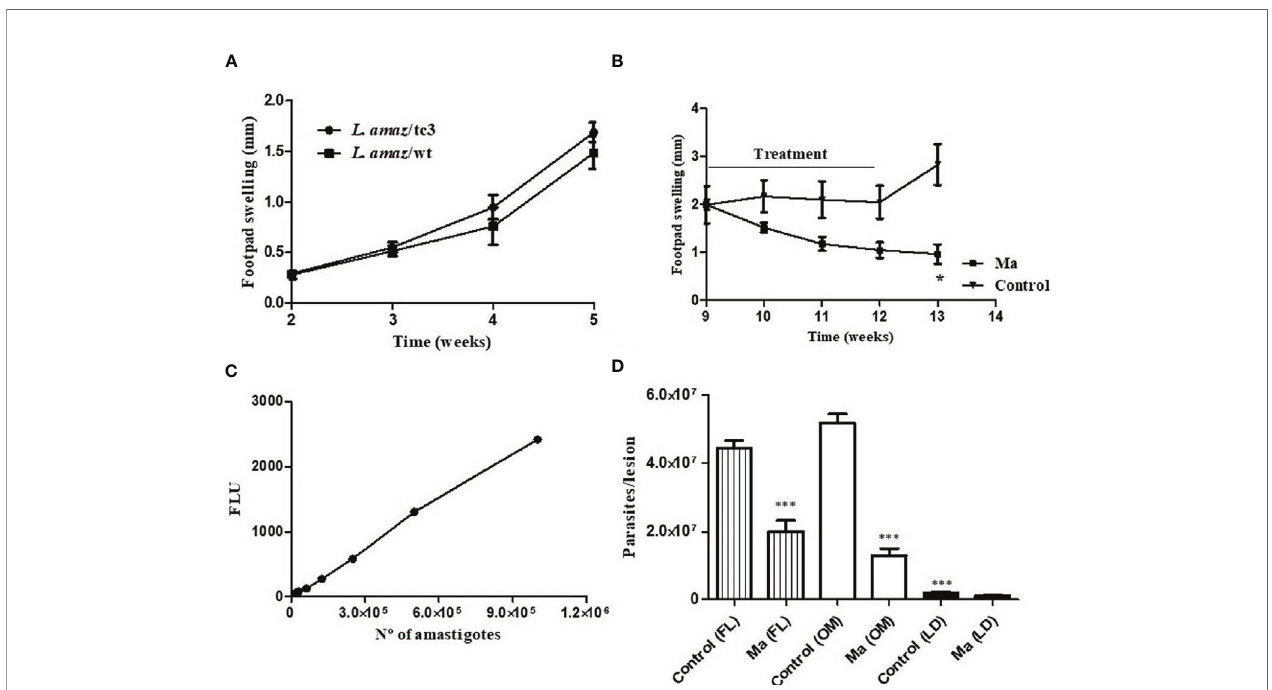
FIGURE 3 | (A) The infectivity of L. amaz /tc3 in BALB/c mice was similar to the wild strain ( L. amaz /wt). (B) Reduction in the footpad swelling in BALB/c mice infected with L. amaz /tc3 and treated with meglumine antimoniate (MA) (120 mg Sb/kg/day) ( p < 0.05). (C) Calibration curve, fl uorescence and number of amastigotes isolated from mice infected with L. amaz /tc3 (r 2 = 0.99, p < 0.0001). (D) Parasite load quanti fi ed, at week 13 of the experiment in mice treated with Ma and control group, by fl uorescence method (FL), optic microscope (OM) and limiting dilution (LD). Statistical signi fi cance was assessed using Mann-Whitney U-test t (* p < 0.05) and ANOVA (*** p < 0.001). Data (mean ± SD) are from a representative experiment ( n = 5